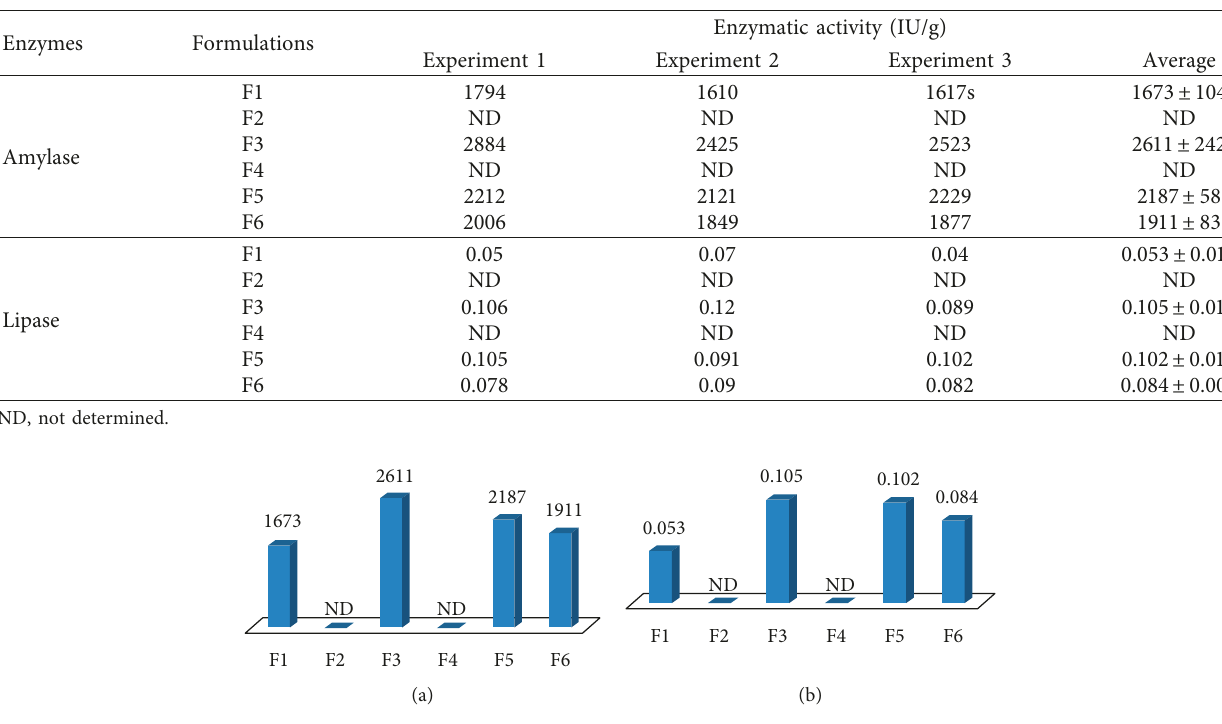
Figure 6: Enzymatic activity of soybean shoots grown from seeds treated with formulations of different nutrient compositions: amylase activity (IU/g) (a) and lipase activity (IU/g) (b) 48h after